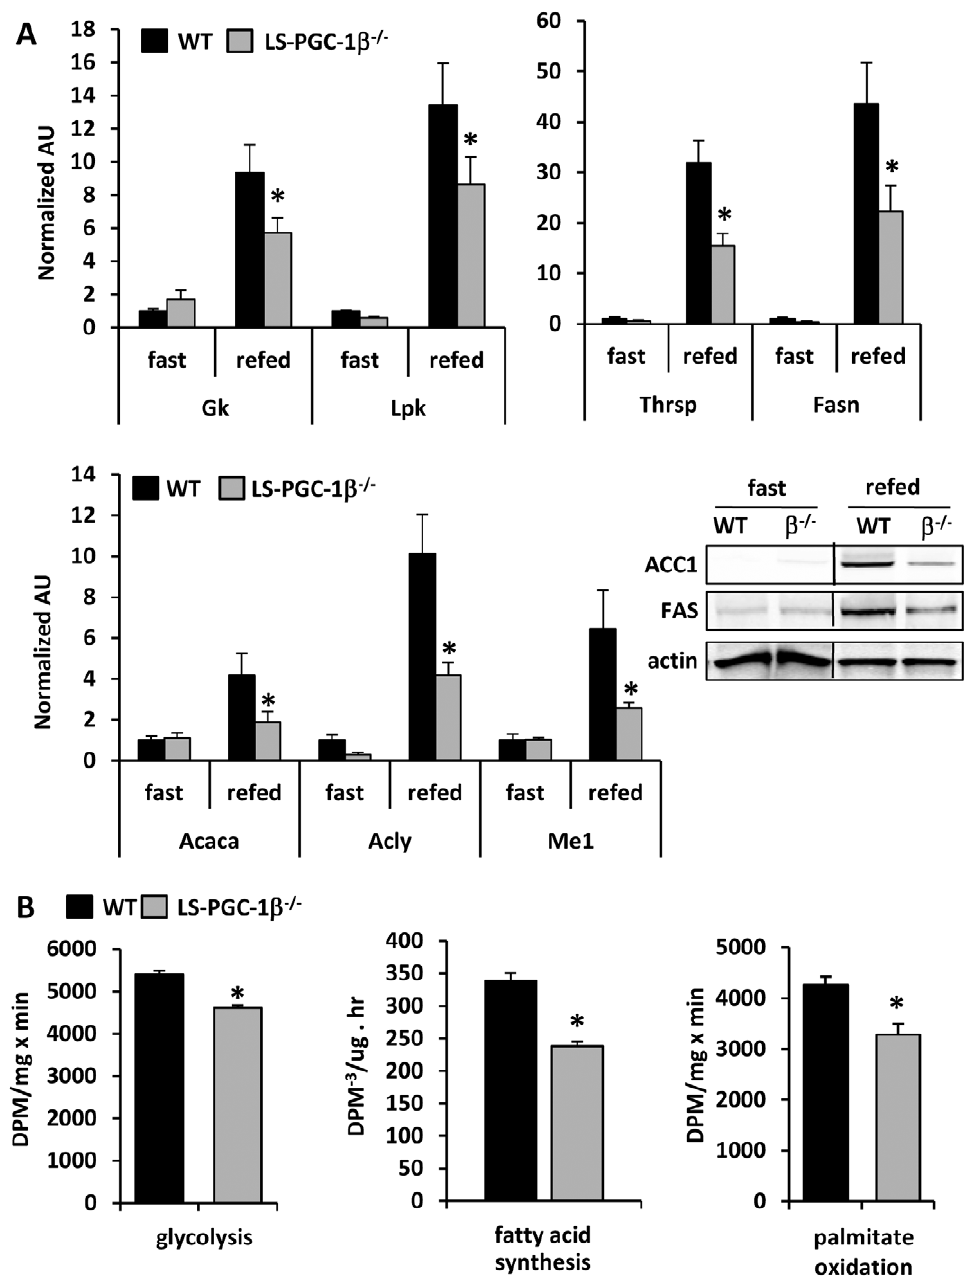
Figure 6. Blunted induction of lipogenic gene expression and lipogenesis in LS-PGC-1 b 2 / 2 mice in response to fasting-refeeding. The graphs depict the expression of glycolytic and lipogenic gene expression in WT and LS-PGC-1 b 2 / 2 mice given either fasted 40 h or fasted 24 h and then refed for 16 h with high sucrose diet (n=6). Representative western blots for corresponding proteins in same mice are shown. *P , 0.05 versus WT mice of the same treatment group. The graphs depict the rates of glycolysis, fatty acid synthesis, and palmitate oxidation in hepatocytes from WT and LS-PGC-1 b 2 / 2 mice after 24 h fasting and then refeeding for 16 h with high sucrose diet. *P , 0.05 versus WT mice.